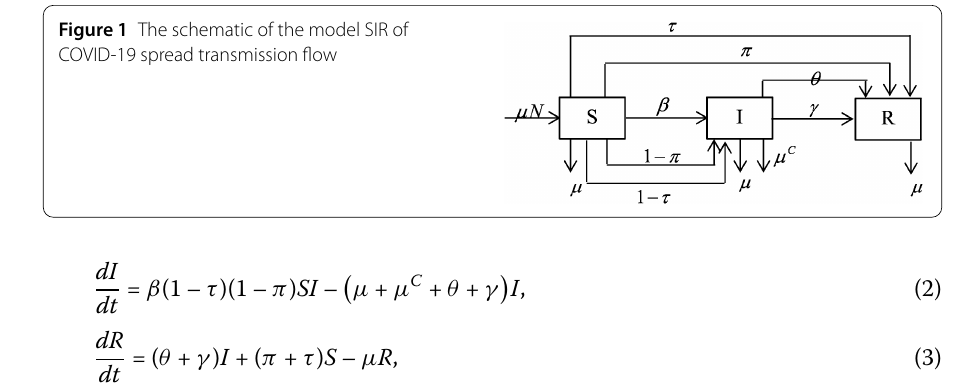
Figure 1 The schematic of the model SIR of COVID-19 spread transmission